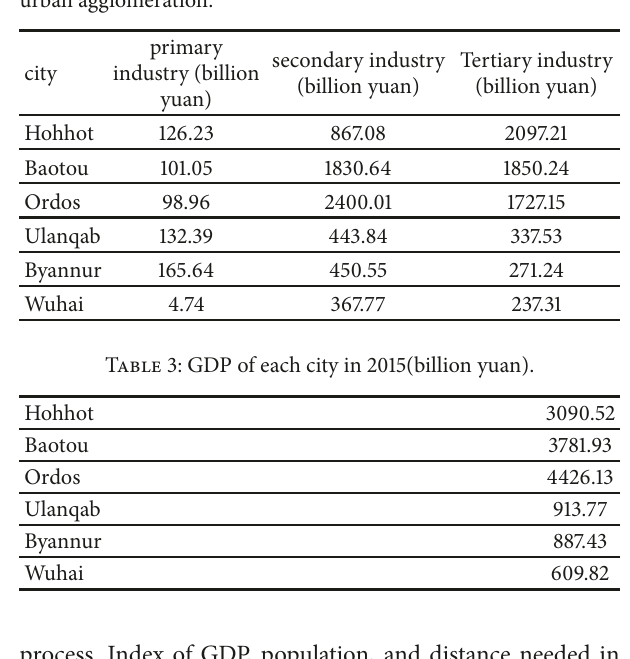
Table 1: The division of transport supply and demand structure equilibrium level.